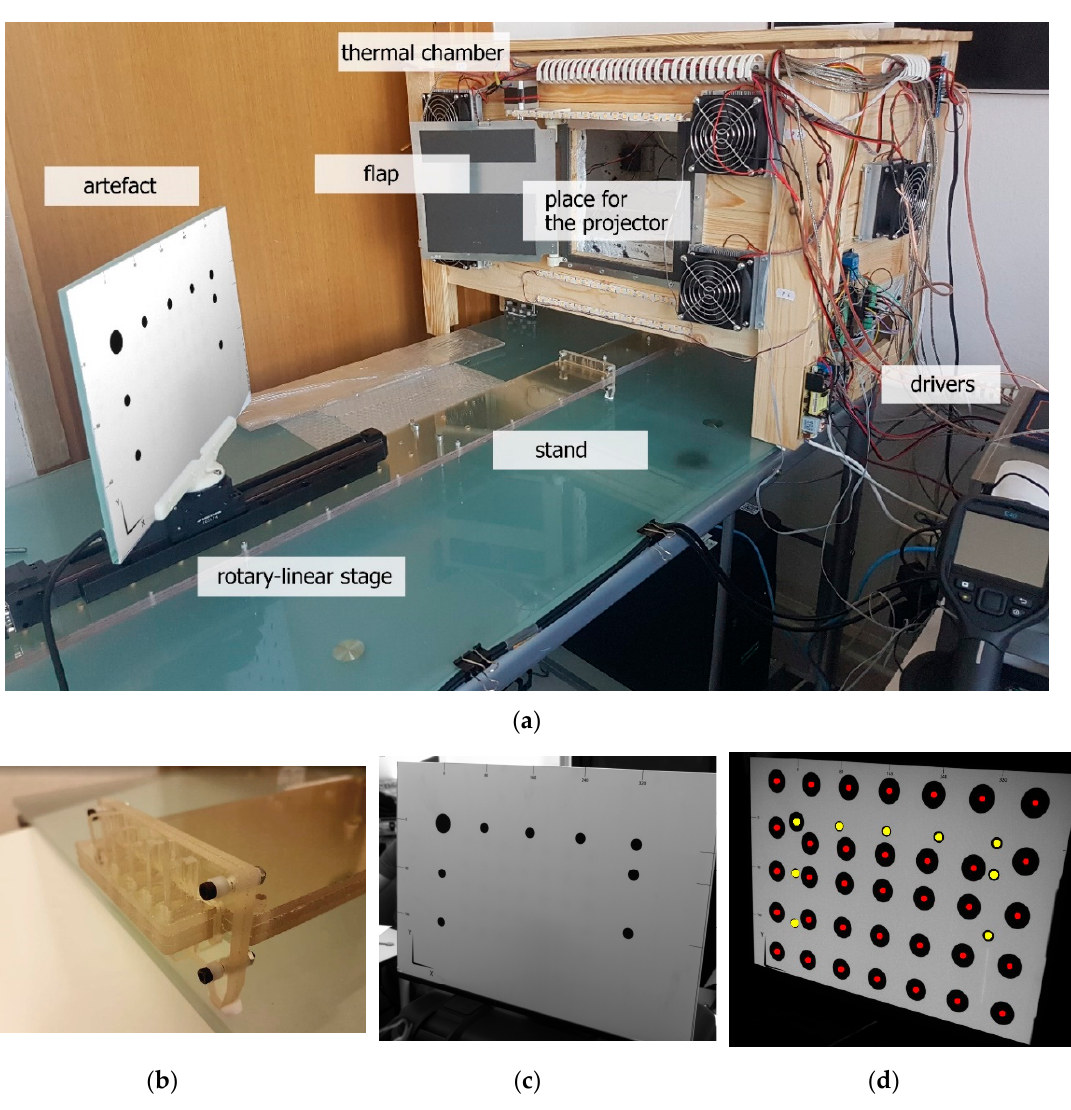
Figure 2. Test stand and the validation artefact: ( a ) overview of the test stand, with the Robax stand and the thermal chamber: ( b ) the athermalized design of the stand — the Robax keys preventing the thermal deformation of the glued connection of the stand; ( c ) the validation artefact with the matrix of printed markers; and ( d ) the same validation matrix (markers printed on the artefact are marked with yellow dots) with the projected matrix of projector-related markers (marked with red dots).